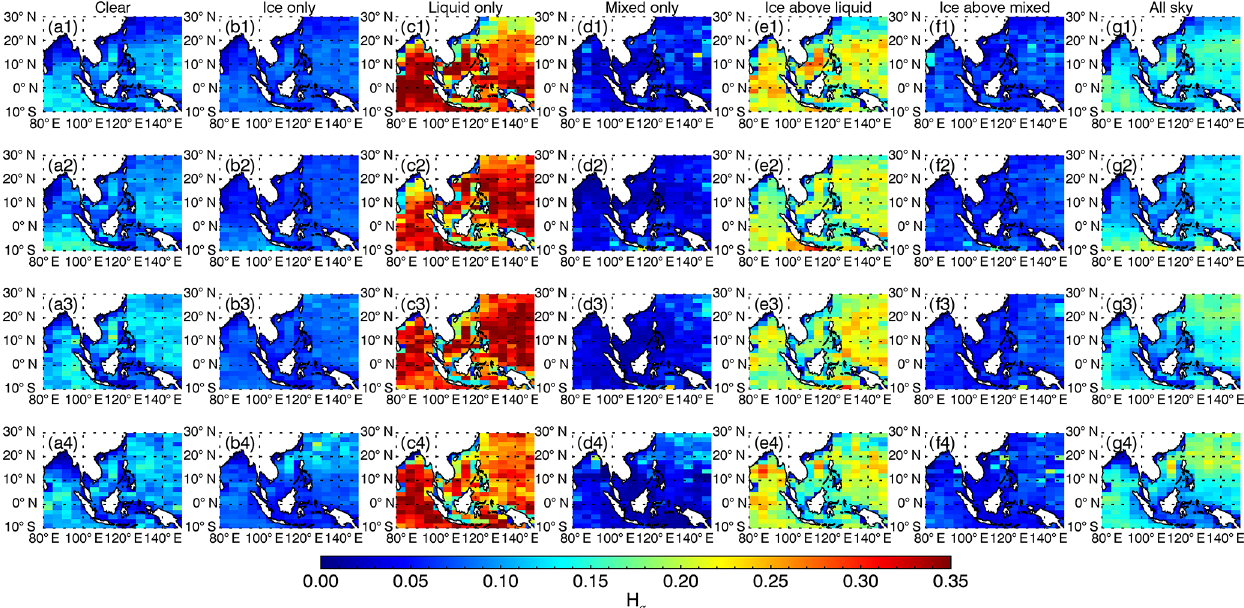
Figure 8. Spatial distributions of H σ for clear sky, the five cloud groups, and all sky from panels (1) to (4) for MAM, JJA, SON, and DJF, respectively.